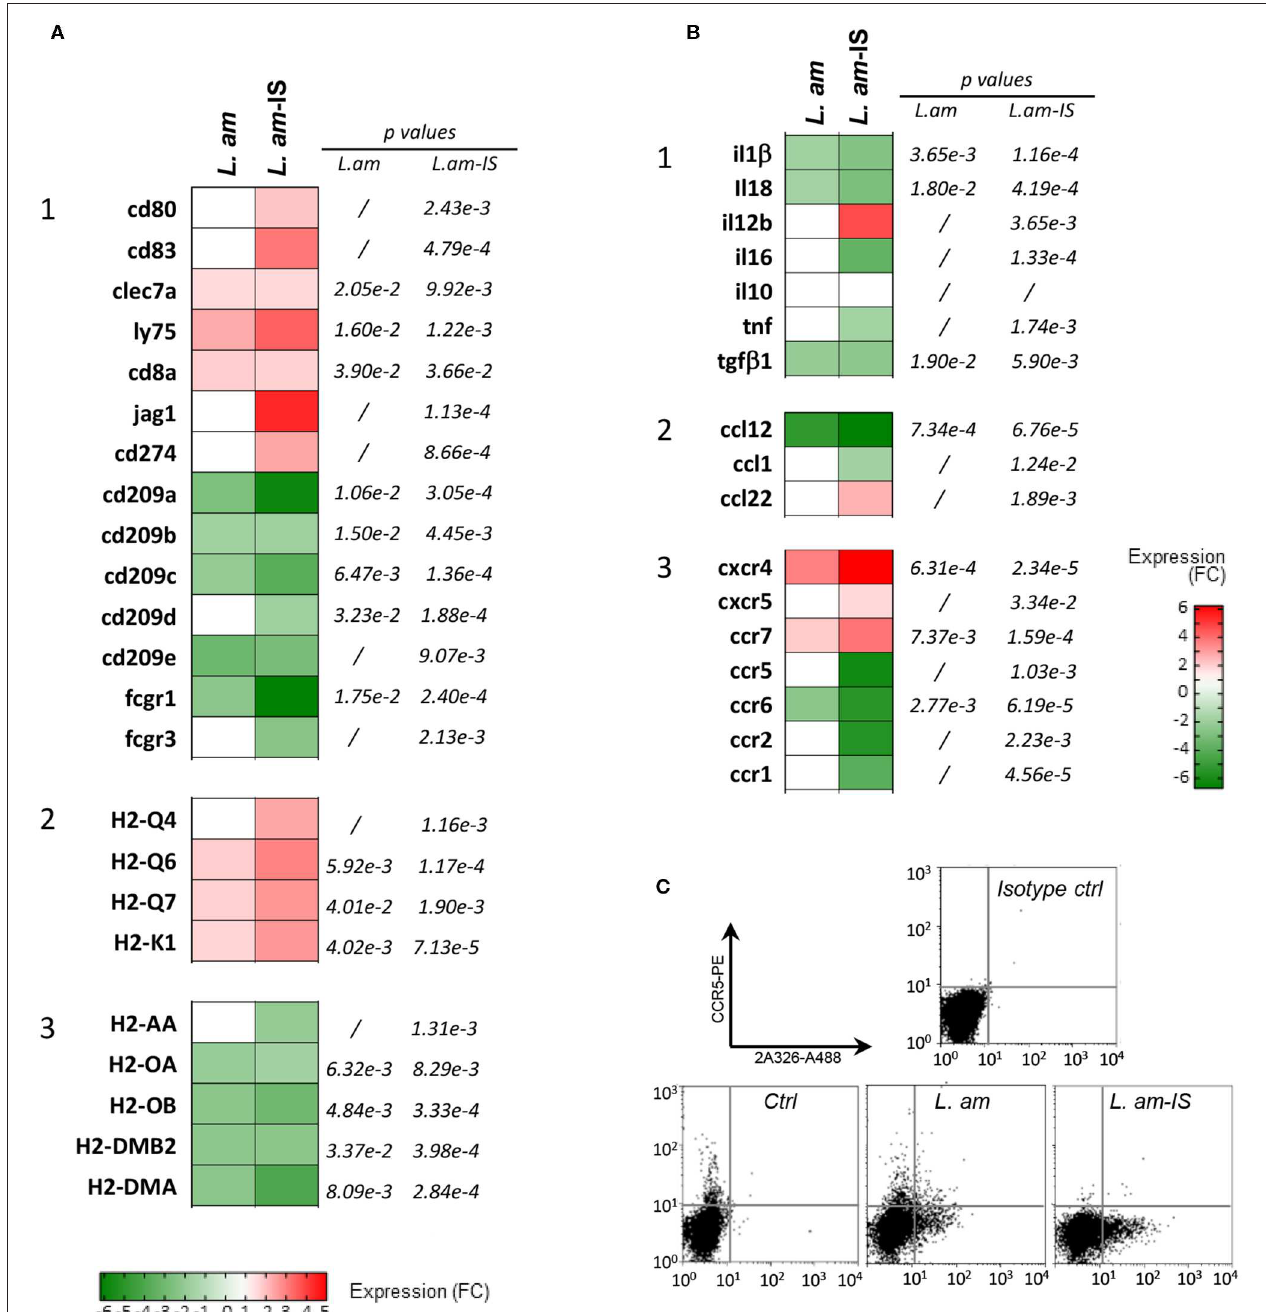
FIGURE 4 | Expression analysis of genes related to the maturation process in Leishmania -infected DCs. (A,B) Affymetrix analyses were performed on sorted DCs infected with non-opsonized ( L. am ) or Ab-opsonized ( L. am -IS) Ds Red2-transgenic amastigotes. Transcriptional modulation of genes involved in the DC maturation process are displayed as the mean fold change values calculated using uninfected sorted DCs as a calibrator. (A) Expression of genes related to maturation and antigen presentation. Heatmaps representing the expression modulation of genes coding for costimulatory molecules and surface receptors (1), MHC I (2), and MHC II (3) molecules. (B) Expression of chemokine and cytokine genes. Heatmaps representing the modulation of genes coding for cytokines (1), chemokines (2), and chemokine receptors (3). (C) FACS analysis of CCR-5 expression levels. DCs from unsorted cultures were analyzed by FACS for the expression of CCR5, a marker that is rapidly lost during the maturation process. Infected cells were detected using the amastigote-specific, Alexa Fluor-488 conjugated mAb 2A3-26.